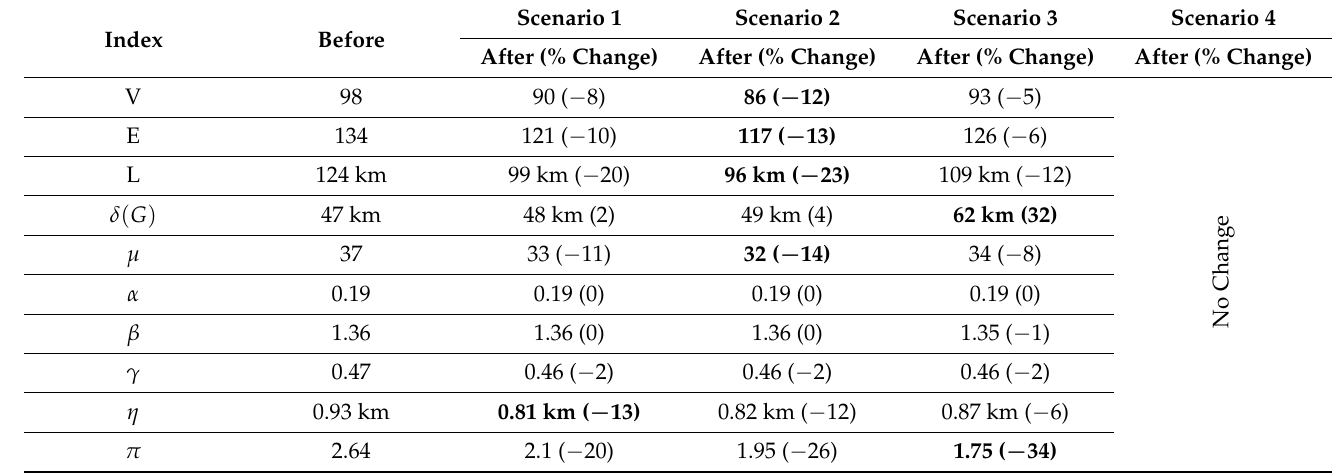
Table 11. Transportation network reliability indicators before and after an earthquake.